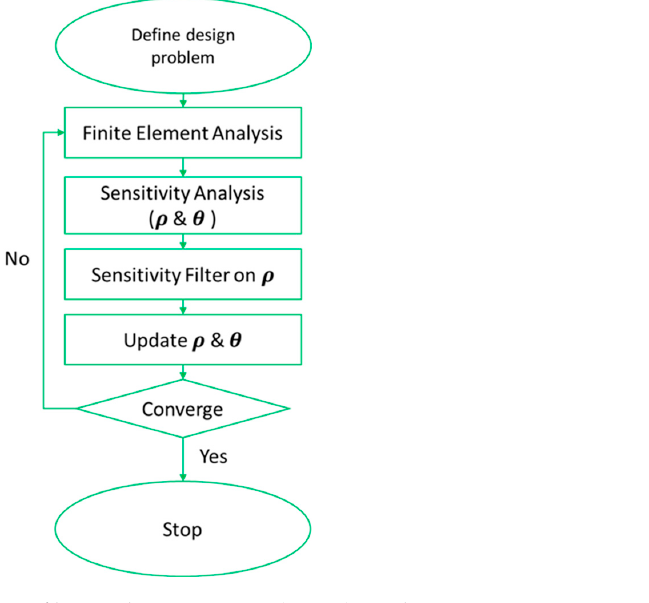
Figure 2. Flow chart for the continuous fiber angle optimization (CFAO) topology optimization process.